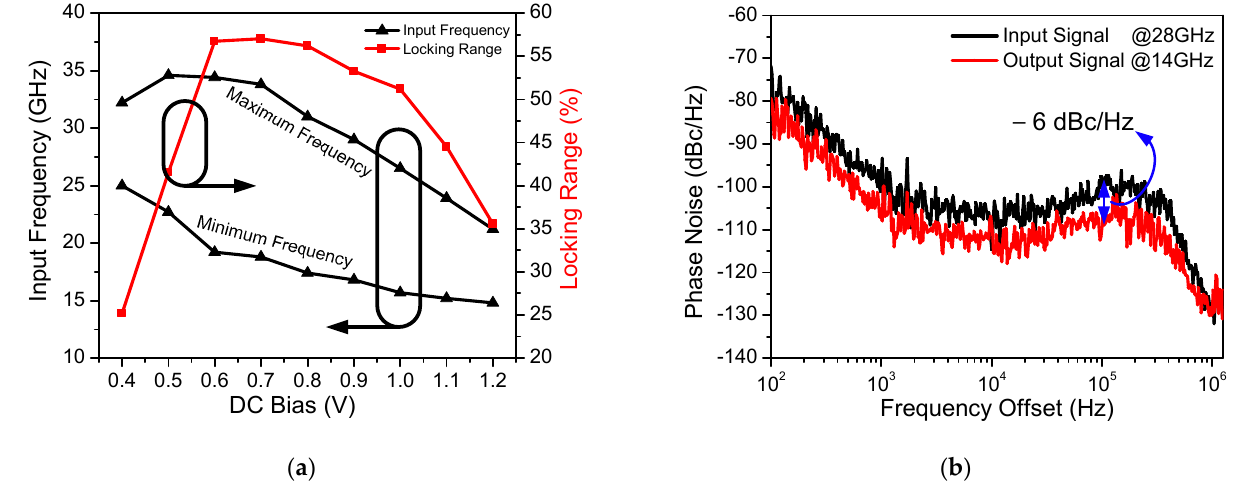
Figure 13. ( a ) Measured maximum and minimum operation frequency of the proposed CR-ILFD with different V inj,DC ; ( b ) Measured phase noise of input and output signal.